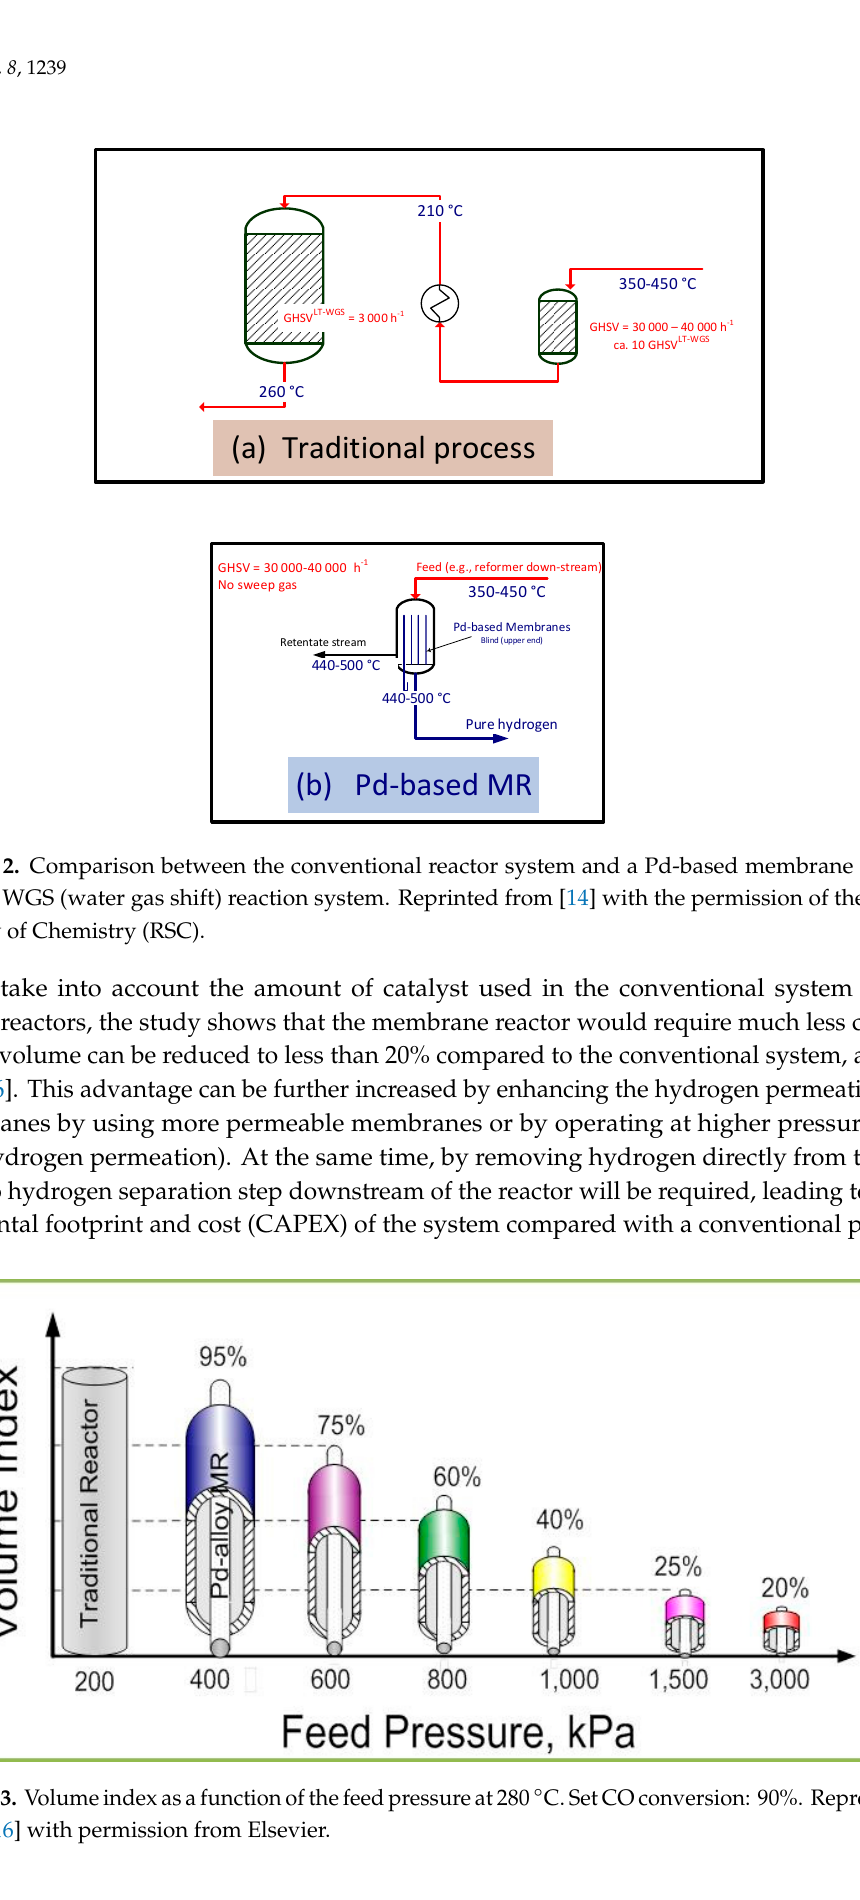
Figure 3. Volume index as a function of the feed pressure at 280 °C. Set CO conversion: 90%. Reproduced from [16] with permission from Elsevier.